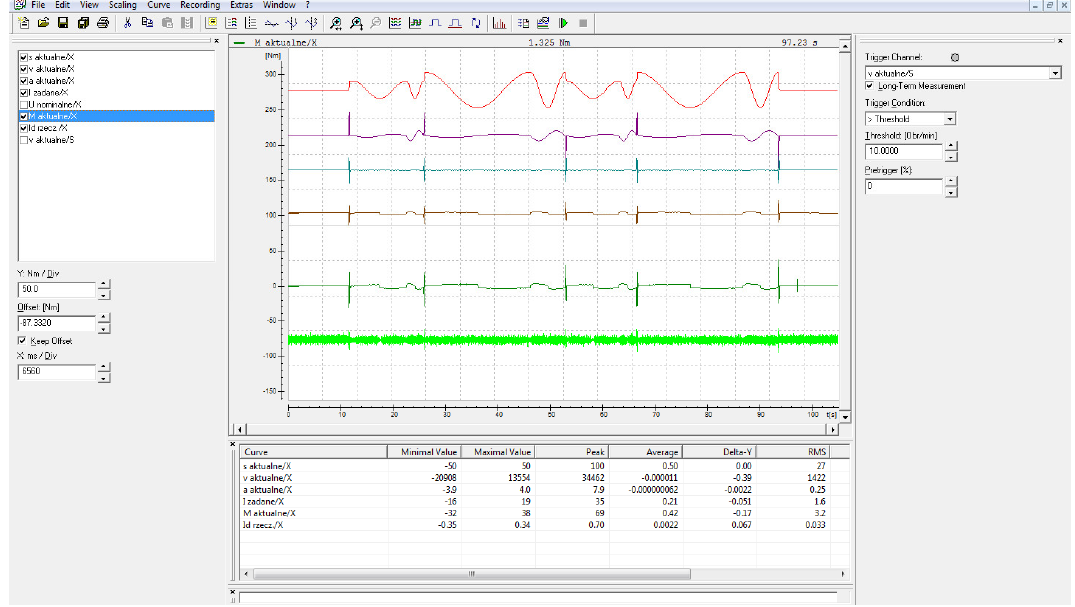
Figure 12. TNCScope software screenshot—acquired data signals with the use of diagnostic connection of the iTNC530 control system (Ethernet TCP/IP; 600 µs sampling time).